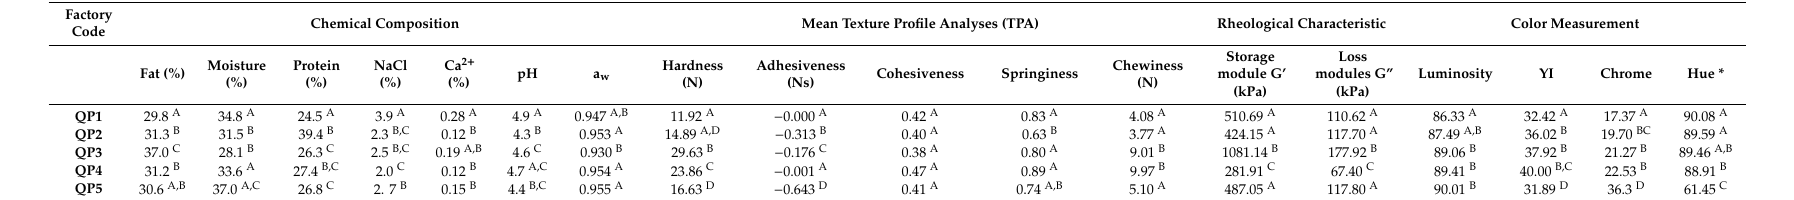
Table 3. Chemical composition of Poro